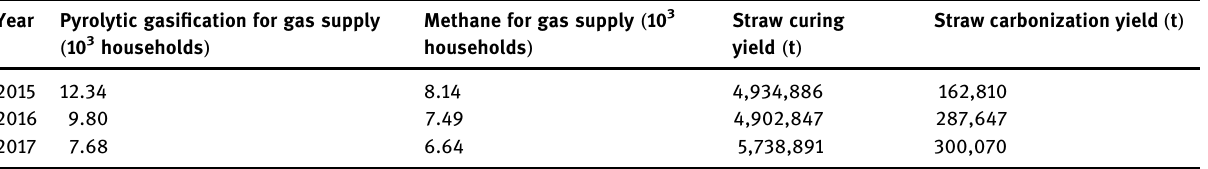
Table 6: Utilization of straw resources in China Year Pyrolytic gasi fi cation for gas supply ( 10 3 households